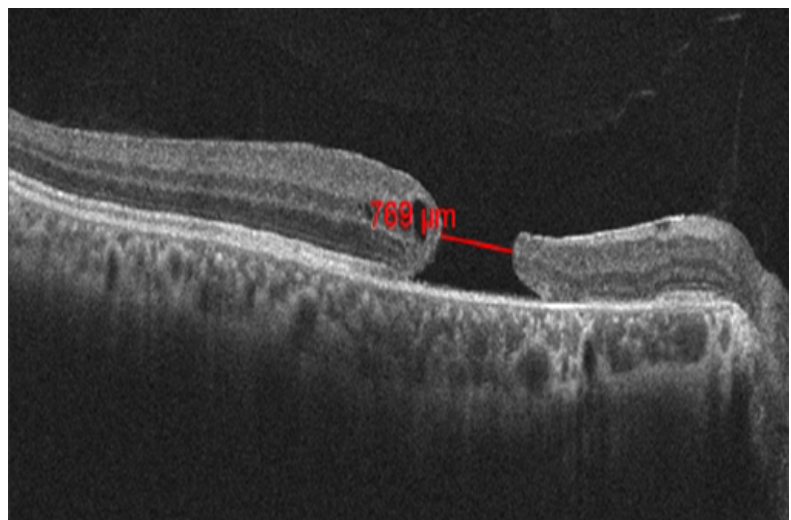
Figure 1: Preoperative optical coherence tomography showing full thickness traumatic macular hole. The minimum linear diameter was 769 µm.